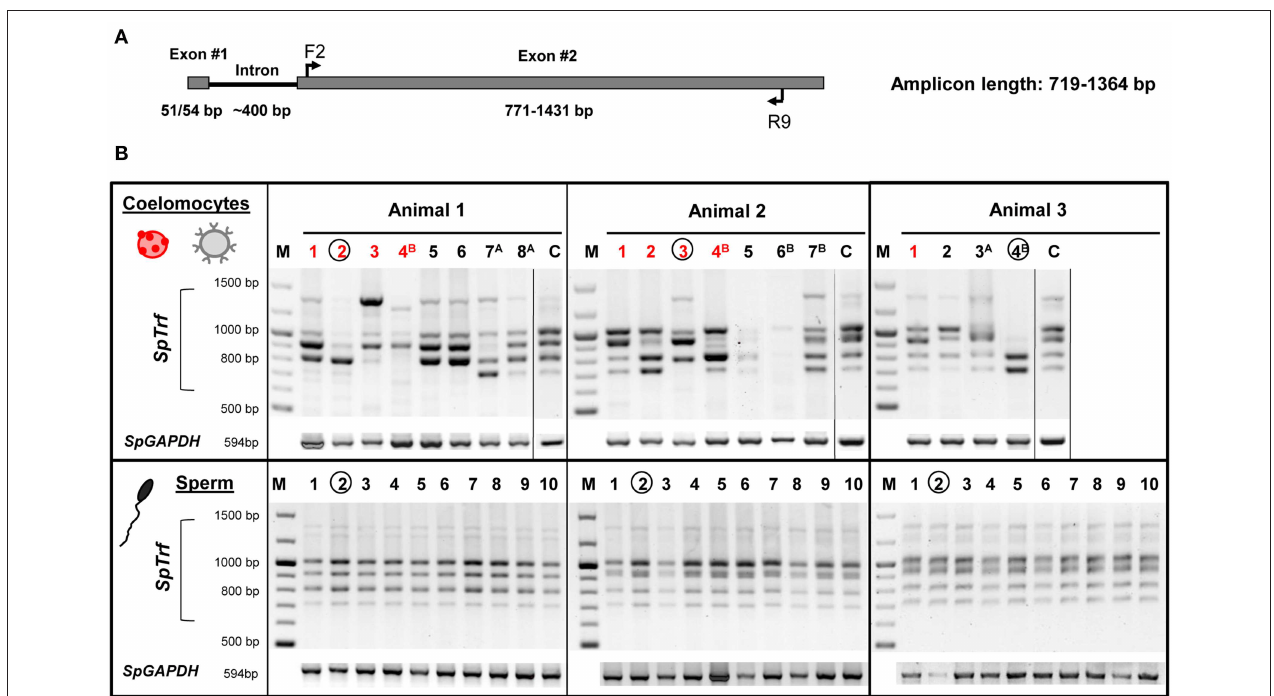
FIGURE 5 | The SpTrf gene family profile is different among single coelomocytes. (A) The standard structure of an SpTrf gene shows the locations of F2 and R9 degenerate primers that were used to amplify most of the second exon. This figure is modified from (6). (B) SpTrf gene amplification profiles from single coelomocytes and single sperm from three sea urchins that were processed for WGA. The upper panel shows the amplicon patterns from individual coelomocytes from three animals. Both single red spherule cells (red numbers) and single small phagocytes (black numbers) show variable sizes of the SpTrf gene amplicons. Circled lane numbers indicate samples for which amplicons were sequenced and include one coelomocyte and one sperm from each animal. Superscript letters associated with lane numbers indicate the time after immune challenge with Vibrio diazotrophicus : A , 1 day post challenge; B , 2 days post challenge. The controls (C) for each of the three sea urchins show amplicons from ∼ 10 6 coelomocytes that were not processed for WGA. The lower panel shows the amplicon patterns of 10 single sperm cells from each animal. SpGAPDH is a single copy gene that was employed as the positive control for all samples to verify that genomic DNA after the WGA process would support